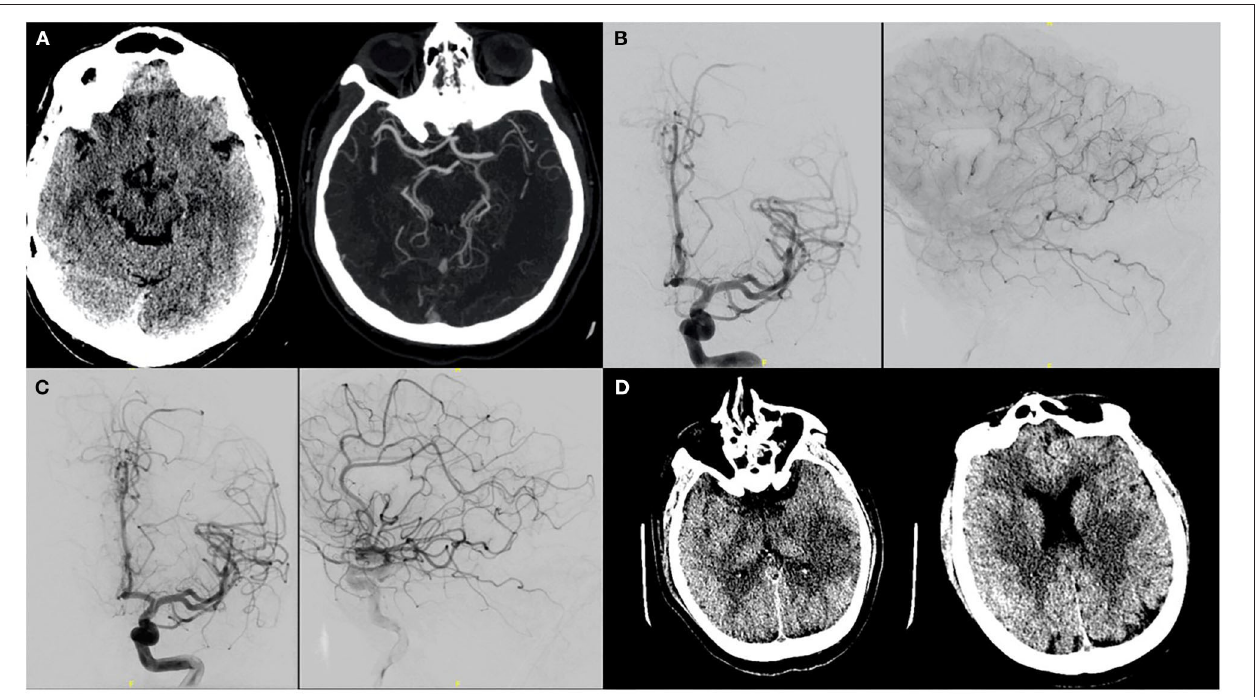
FIGURE 1 | A patient with no significant past medical history presented to the ER after 8 days of viral illness and was on Azithromycin therapy after testing positive on day 3. NIHSS was 18 on presentation secondary to a left MCA syndrome. (A) CT/CTA confirmed a left M1 thrombus. As presentation was within 4.5 h of symptoms onset, IV tPA was administered. (B) The patient was taken for mechanical thrombectomy and on initial cerebral angiography showed partial recanalization post-TPA and migration of the clot to distal MCA branches. (C) The patient was thus given intra-arterial tPA in these branches. (D) Post procedurally, infarcts in the left putamen as well as temporal and parietal regions were seen. On last follow-up patient’s mRS was